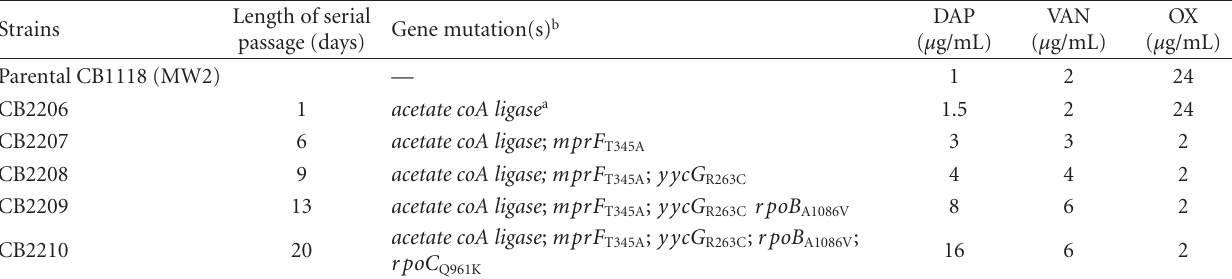
Table 1: List of strains and